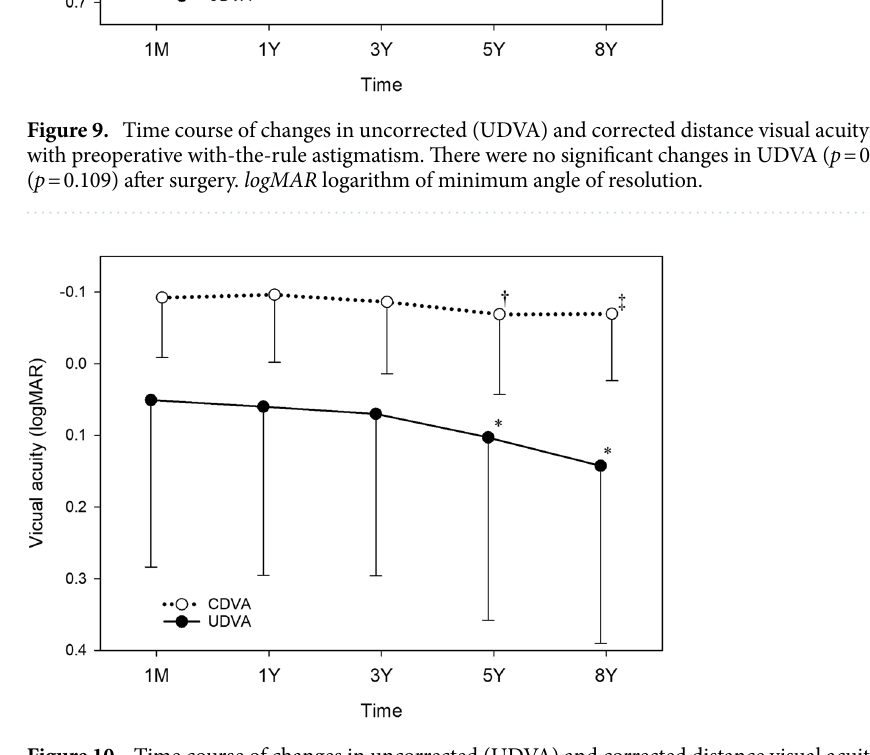
Figure 10. Time course of changes in uncorrected (UDVA) and corrected distance visual acuity (CDVA) in eyes with preoperative against-the-rule astigmatism. UDVA ( p < 0.001) and CDVA ( p < 0.001) showed a significant decline after surgery. UDVA at 5 years (* p = 0.009) and 8 years (** p < 0.001) postoperatively was significantly worse than UDVA at 1 month postoperatively. CDVA at 5 years († p = 0.003) and 8 years (‡ p = 0.002) after surgery was significantly worse than CDVA at 1 month postoperatively. logMAR logarithm of minimum angle of